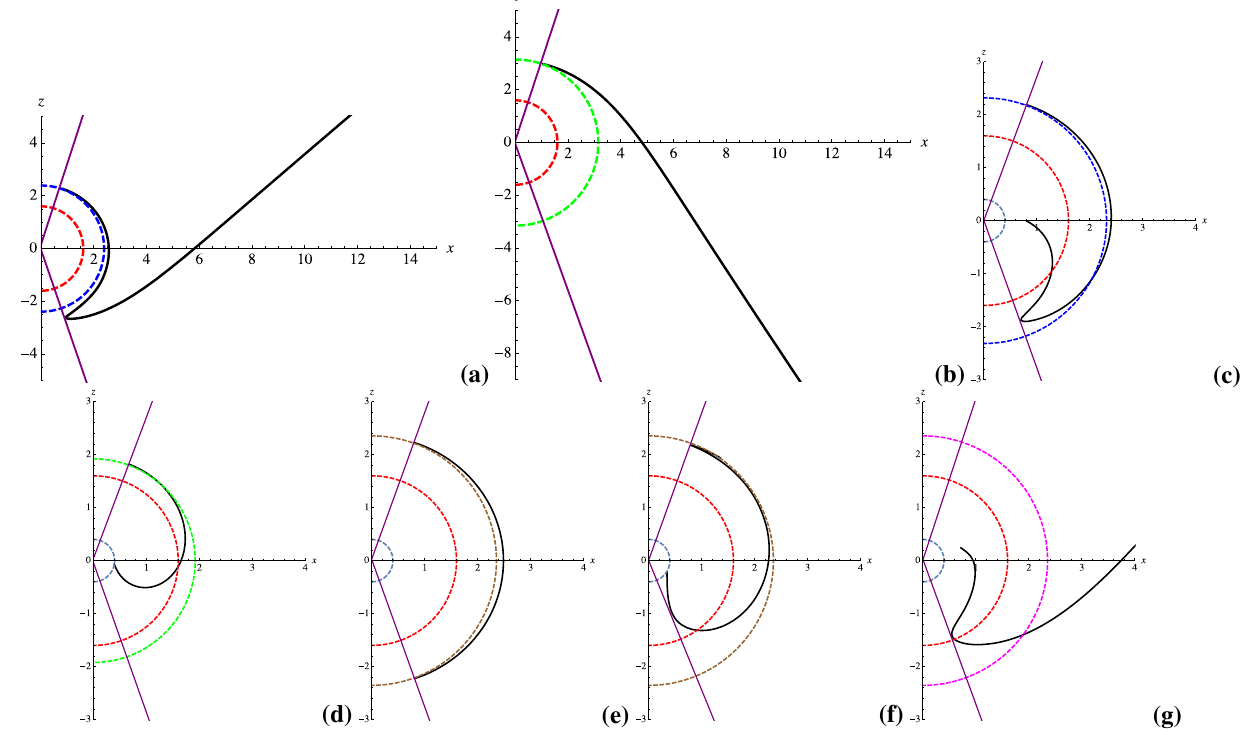
Fig. 8 The cross-sectional behaviors of the deflecting, critical, and capturing trajectories, for the case of ˜ η > 0, inside the cone of confine- ment, in the z - x plane. The diagrams indicate (a) DFK for ω 0 = 0 . 755,